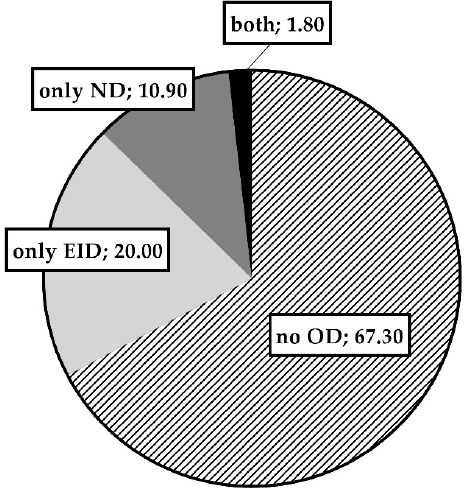
Figure 3. Percentage of patients not presenting oxygen desaturation (no OD), presenting exercise- induced desaturation only (only EID), nocturnal desaturation only (only ND), and both exercise and nocturnal desaturation (both).